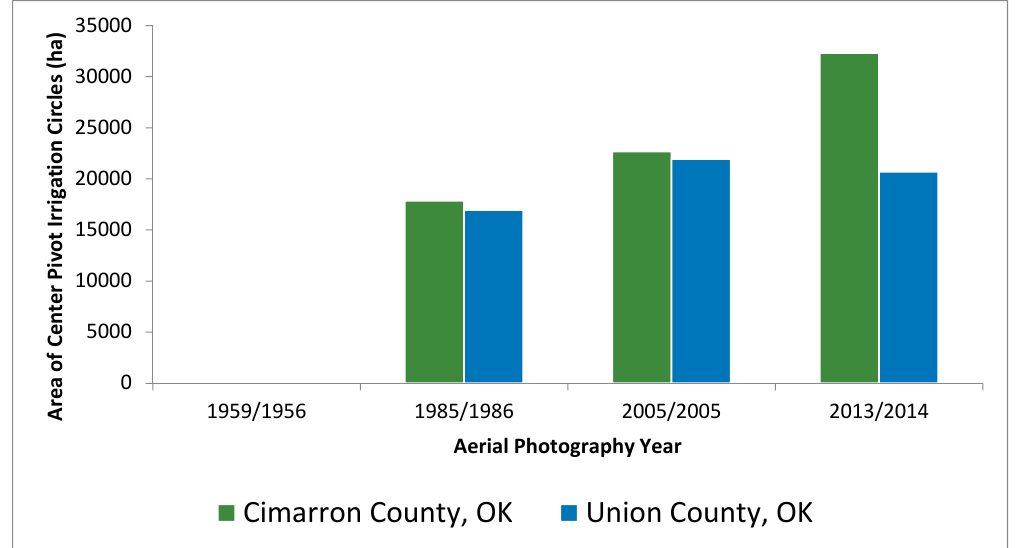
Figure 4. Area of land (ha) under center pivot irrigation within Cimarron County, OK and Union County NM, respectively, 1956–2014.